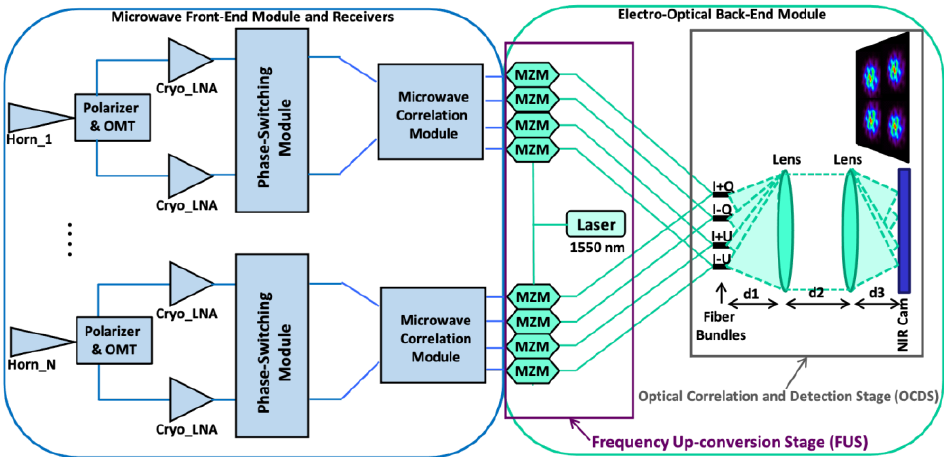
Figure 1. Simplified block diagram of the polarimeter demonstrator with correlation/detection in the near-infrared (1550 nm). Reproduced with permission from F. J. Casas, Sensors; published by MDPI, 2019 [37].